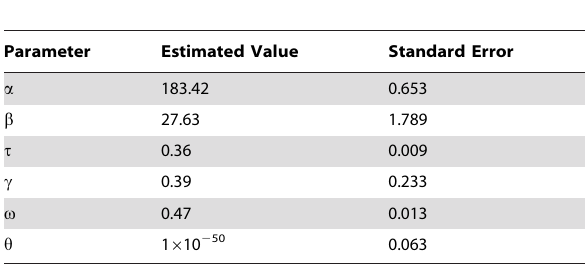
Table 1. Parameter estimates for the production- consumption model of deforestation.